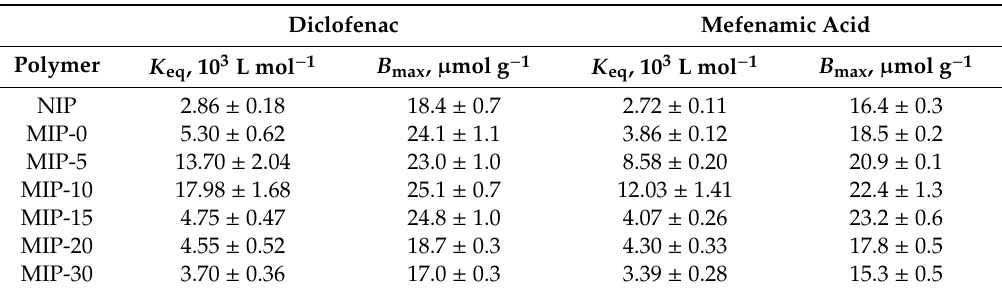
Table 1. Calculated binding parameters ( ± standard error) for diclofenac and mefenamic acid measured on non-imprinted (NIP) and imprinted (MIP) polymers prepared by adding the template at 0, 5, 10, 15, 20, and 30 min from the start of